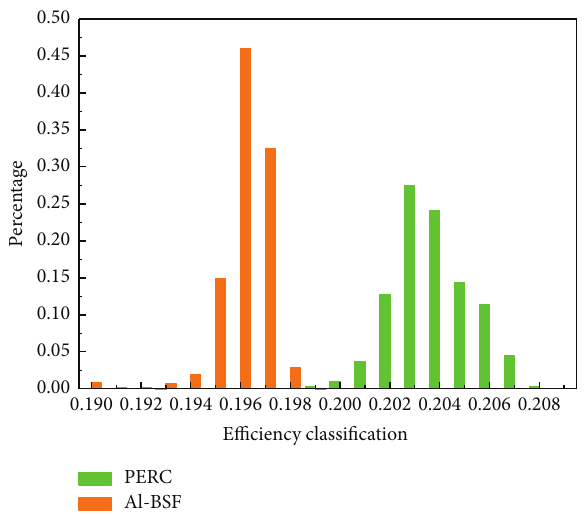
Figure 4: Efficiency distribution of Cz-Si solar cells with Al-BSF and PERC structure. Table 4: Mc-Si cell parameters of Al-BSF and PERC.